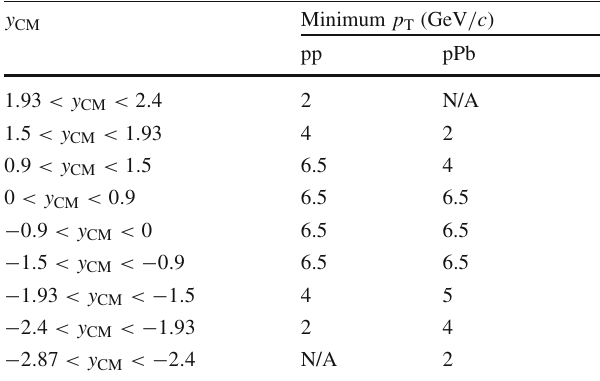
Table 1 Rapidity intervals and associated minimum p T values for the J /ψ cross section measurements in pp and pPb collisions